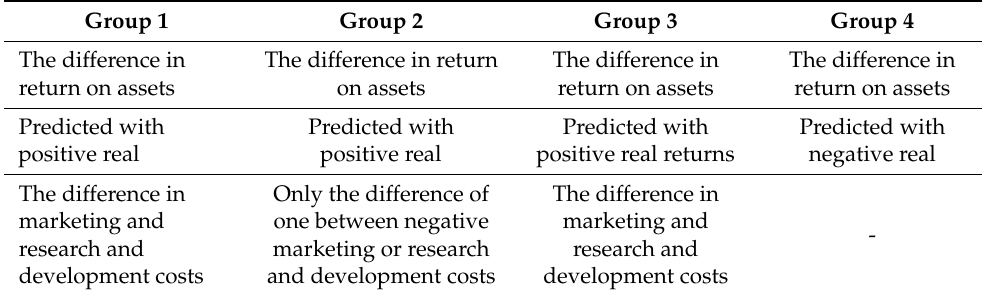
Table 1. The Statistical sample